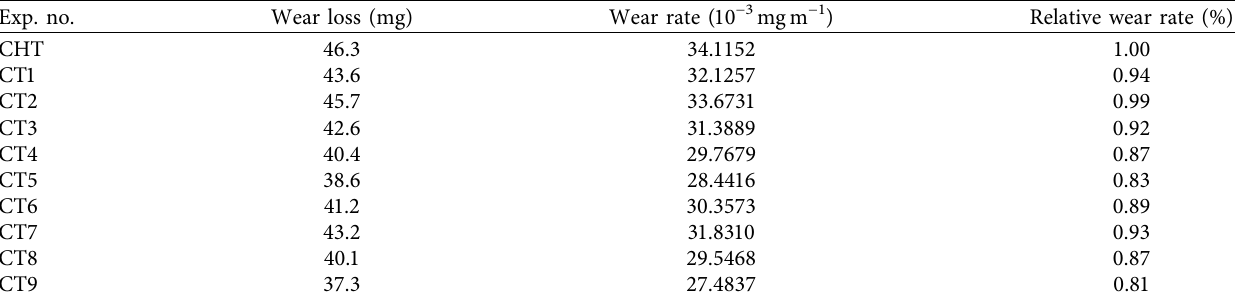
Table 4: Wear test results of CHT and CT specimens.